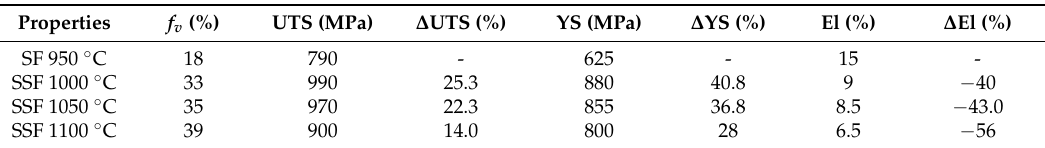
Table 1. The relationship of the Ti 2 Cu fraction on grain boundary ( f v ), tensile strength, and ductility with the forging temperature for Ti14 alloy [33].